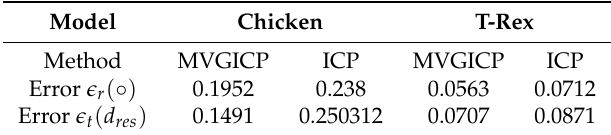
Table 4. Multi-view registration results on the Chicken and T-rex models of the UWA